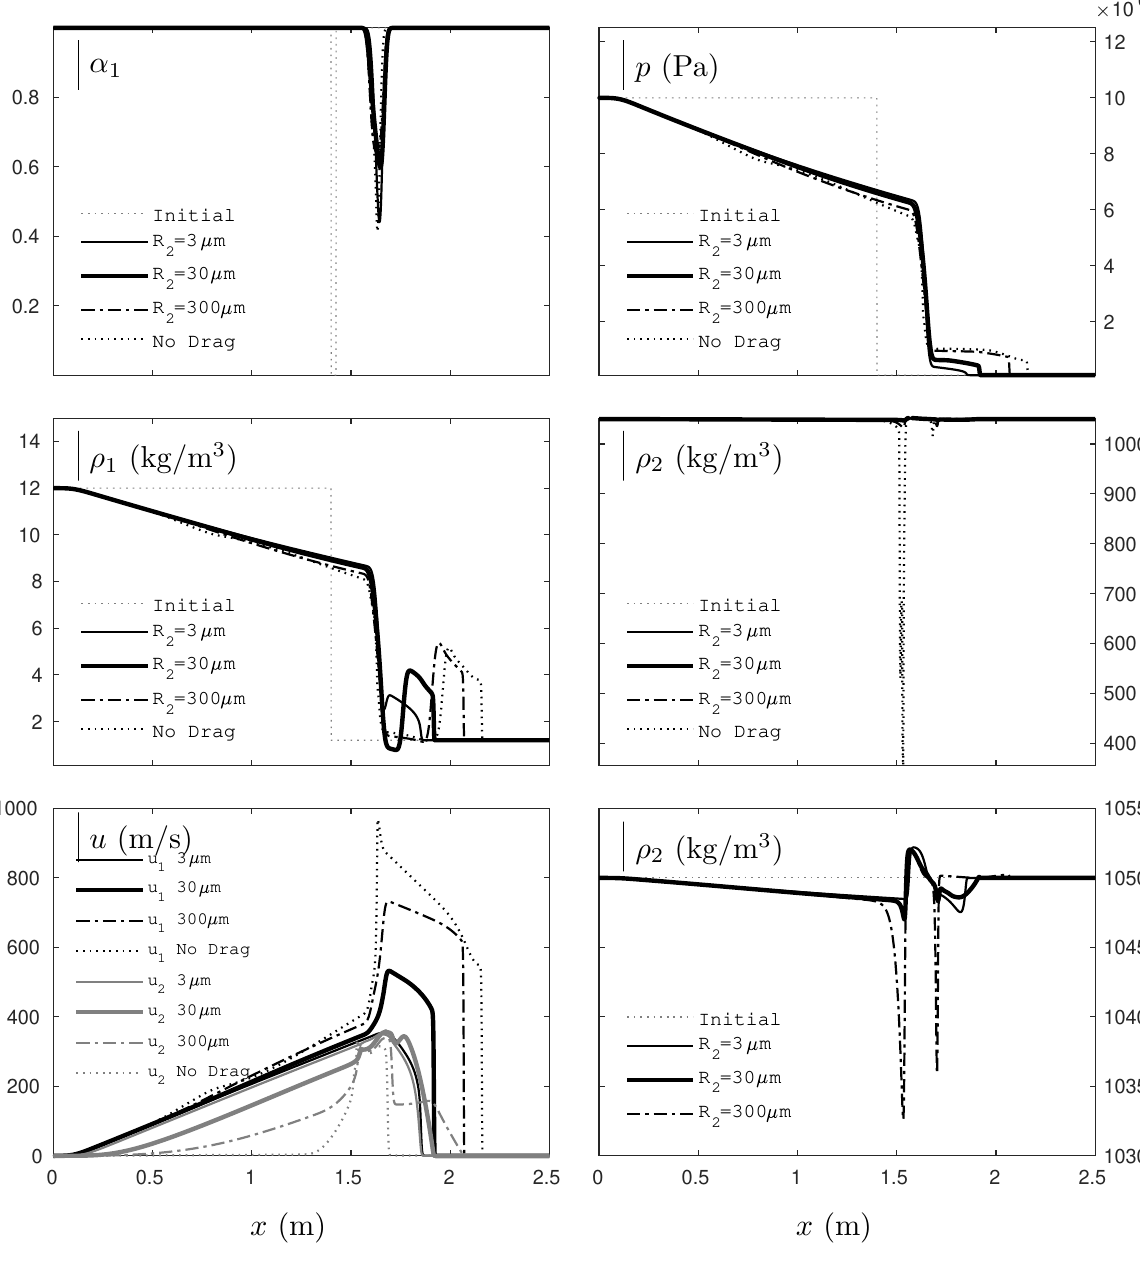
Figure 6. Simplified two-phase explosion test depicted in Figure 5. Comparison of the monodisperse results with various initial radii: R t = 0 = 3 µ m, R t =0 = 30 µ m and R t =0 = 300 µ m. Computation in the absence of viscous drag force is also considered. All results are given at time t = 1.2 ms. The air volume fraction α 1 , the pressure p 1 = p 2 = p , the air and liquid densities, respectively ρ 1 and ρ 2 , as well as the air and liquid speeds, respectively u 1 and u 2 , are presented. A close-up view of the liquid density ρ 2 is also shown.